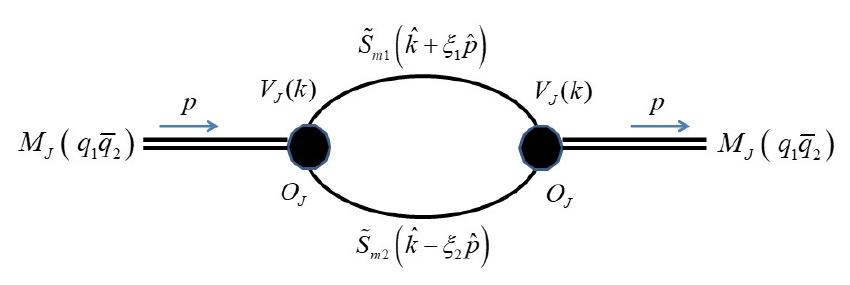
Figure 1. The graphical representation of the meson self-energy function λ N ( − p 2 )